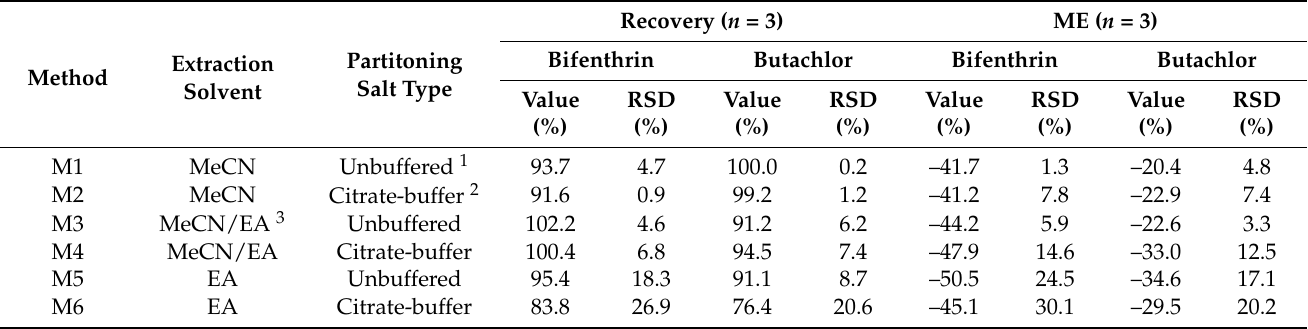
Table 2. Recovery rates and matrix effects (MEs) of bifenthrin and butachlor at 0.1 mg/kg fortification according to various extraction solvents and partitioning salt